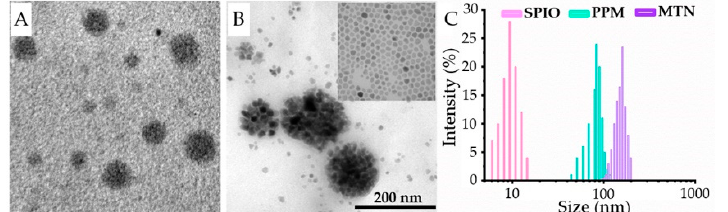
Figure 3. Morphologies (TEM) and particle size distributions (DLS) of PPM, MTN, and SPIO: ( A ) TEM result of PPMs; ( B ) TEM result of MTNs, inset: TEM result of SPIOs; ( C ) DLS results of PPM, MTN, and SPIO.